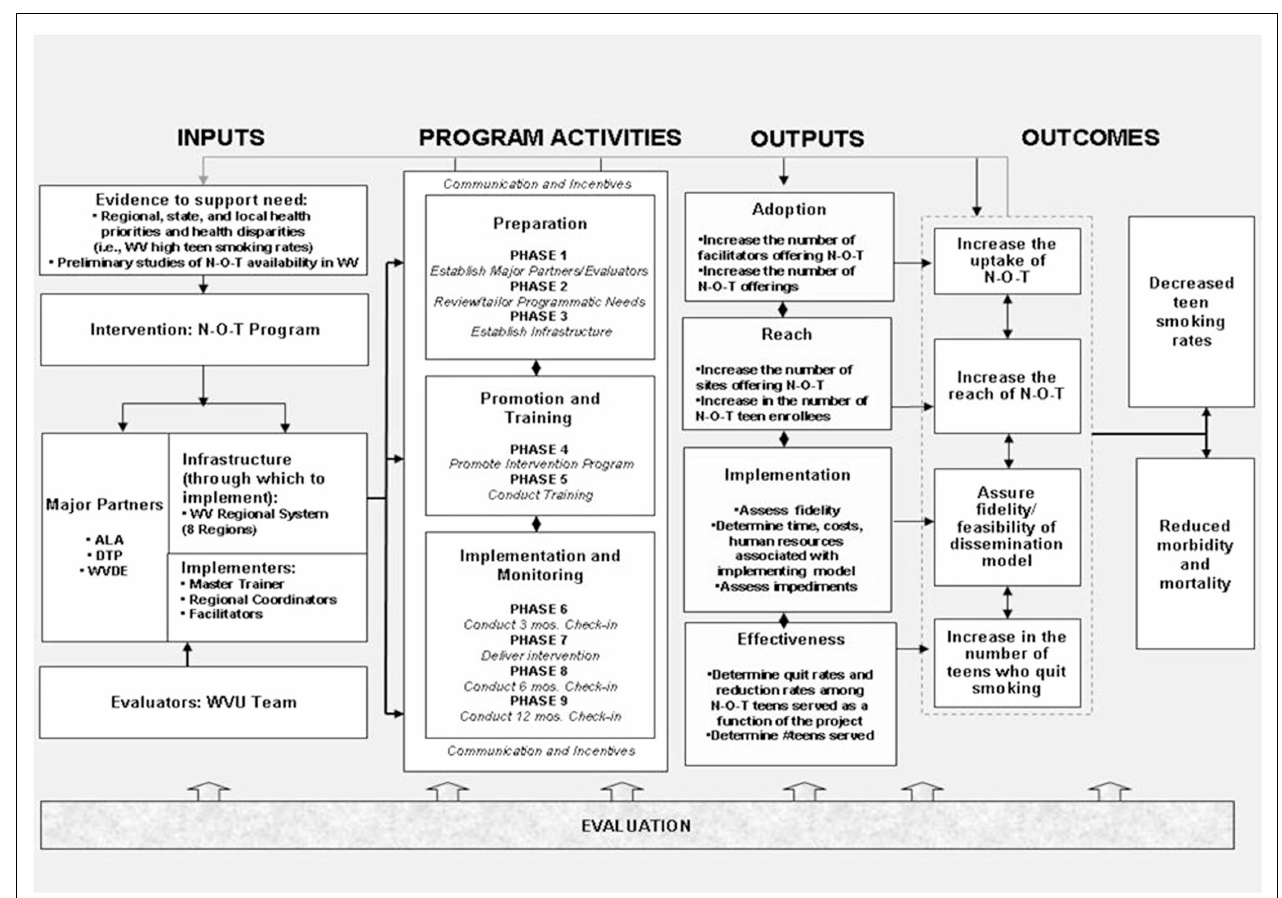
FIGURE 2 | Dissemination trial logic model using key components of REAIM